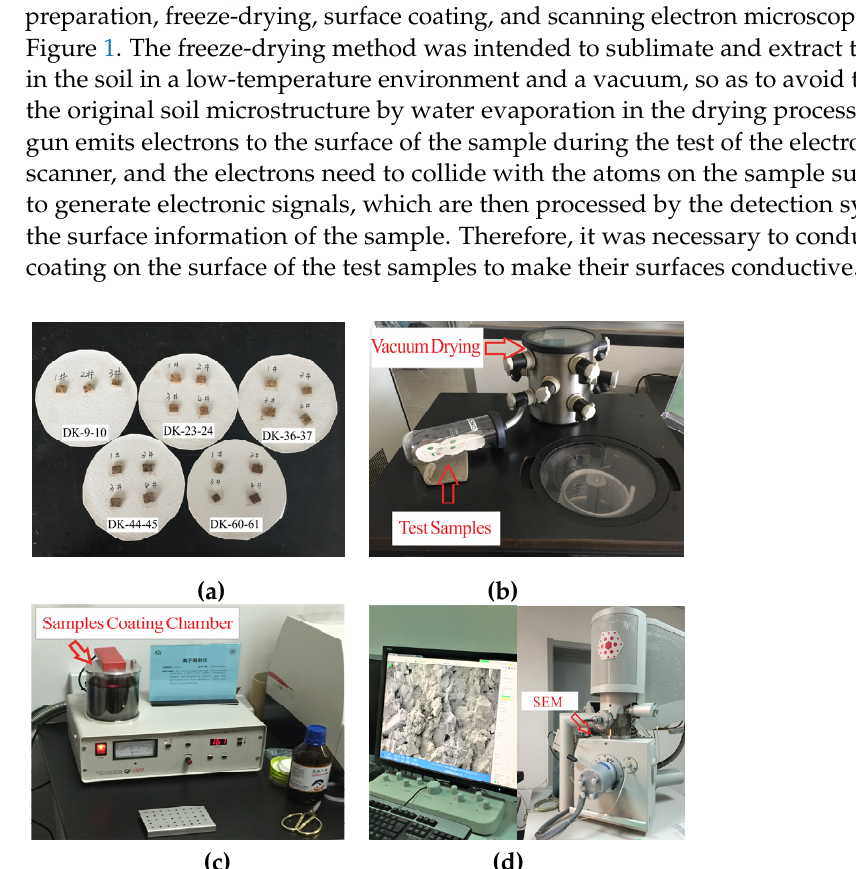
（ c ） Figure 5. The process of the extraction and analysis of the microstructural parameters (the above is magnified 2000 times, and 10000 times below). (a) Image preprocessing; (b) threshold segmentation. (c) morphological processing.